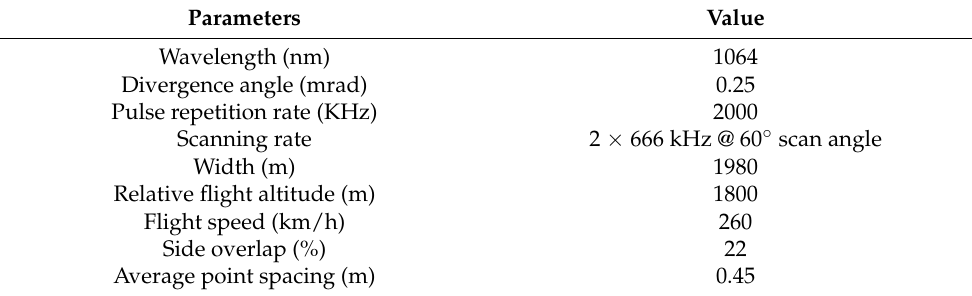
Table 1. Airborne laser scanning system parameters.